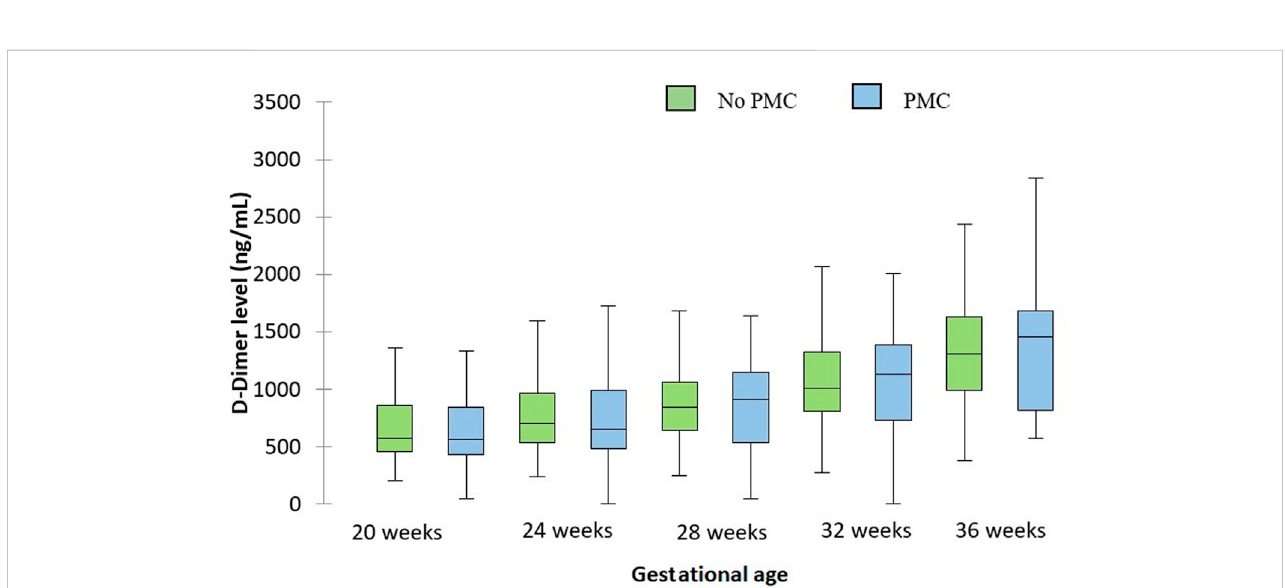
FIGURE 2 Evolution of D-dimer levels during pregnancy depending on the occurrence of PMC. The central horizontal bars are the medians. The lower and upper limits of the boxes are the fi rst and third quartiles. PMC: placenta-mediated